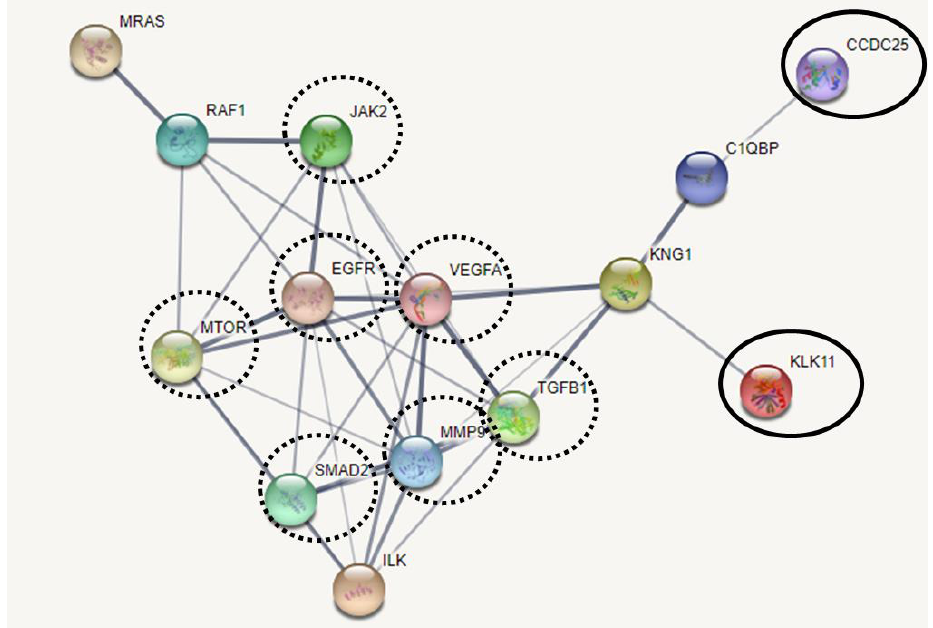
Figure 8. The interaction map of CCDC25, KLK11, and metastasis-related proteins. Protein–ligand interaction was predicted by STRING version 11.0. Protein–protein interactions were represented by solid lines. Stronger associations were represented by thicker lines. Weak associations were represented by thin lines. CCDC25 and KLK11 were represented in solid circles. Metastasis-related proteins were represented by dashed circles.